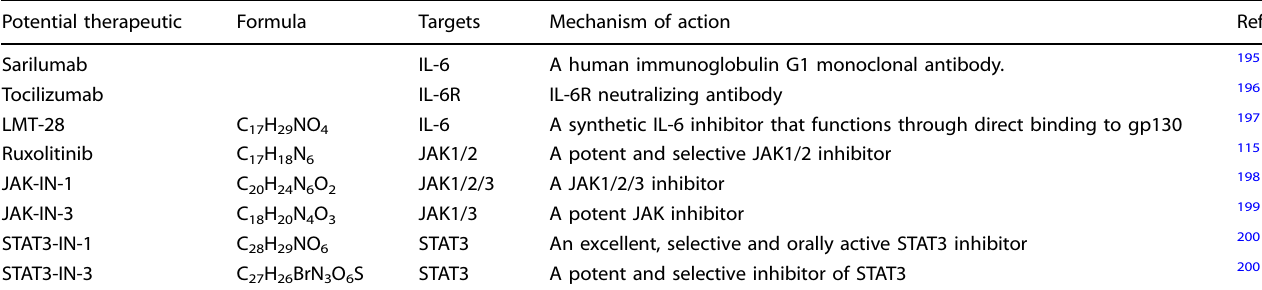
kinase VEGF receptors (VEGFRs) in ECs to elicit various effects. 116 A large body of evidence suggests that an increase in VEGF induces VEGFR2 activation through ERK1/2 and calcium signaling in ECs. 116 VEGFA-stimulated VEGFR2 activation is an important process for modulating multiple biological responses, such as proliferation,